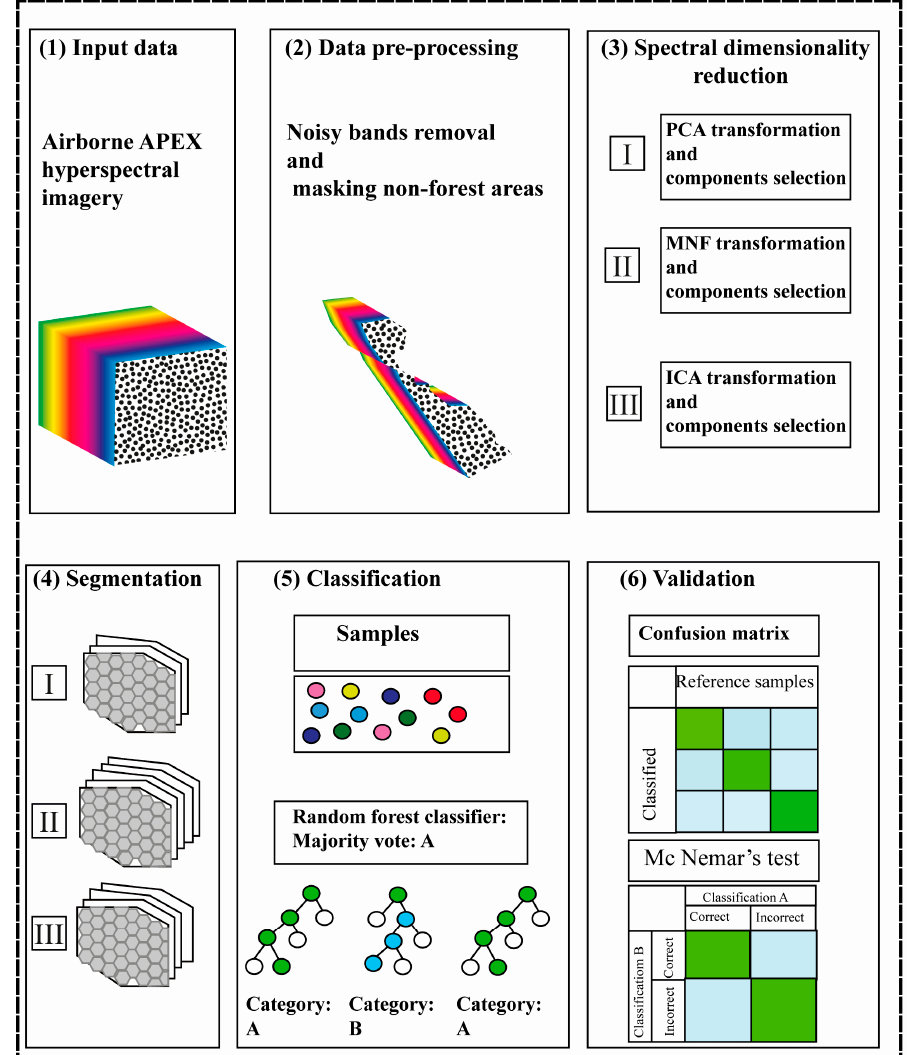
remove noisy bands, and to create non-forest mask; (3) applying three different spectral dimensionality reduction techniques, namely, principal component analysis (PCA), minimum noise fraction (MNF), and independent component analysis (ICA); (4) segmentation of the results using super-pixel segmentation; (5) tree species classification using the random forest (RF) algorithm; and (6) validation of the results and assessment of each dimensionality reduction